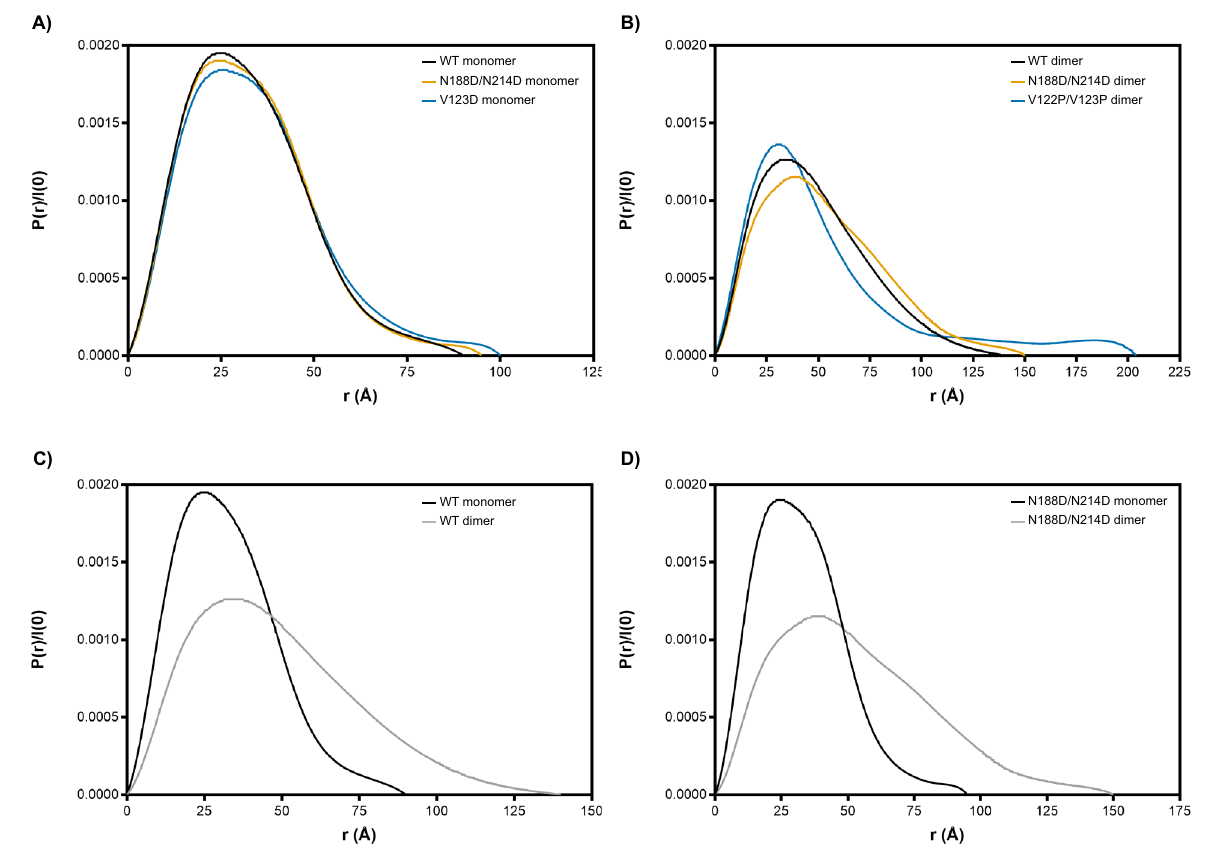
Figure 6. P(r) function analysis for maximum dimension. Overlays of P(r) function plots are shown for monomers ( A ) and dimers ( B ). Comparisons between WT monomer and dimer ( C ) and N188D/N214D monomer and dimer ( D ) are also